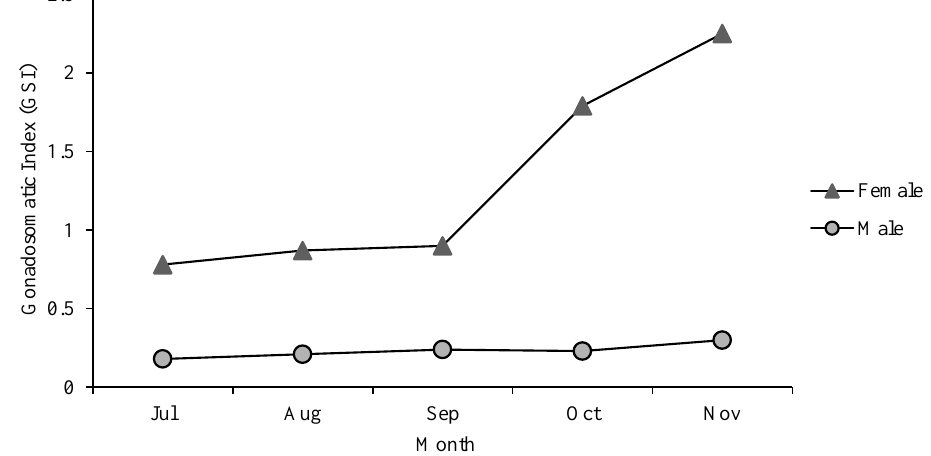
Figure 6. Mean monthly gonadosomatic index (GSI) for Acanthocybium solandri collected from the Western and Central Pacific Ocean.